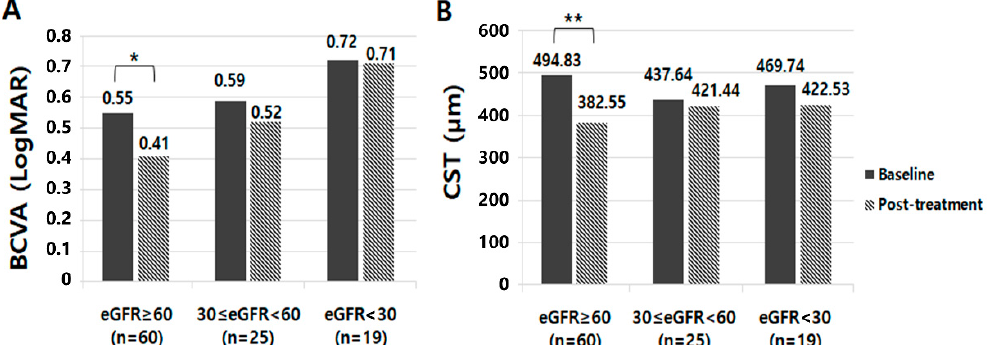
Figure 1. Comparison of the treatment responsiveness of diabetic macular edema after three- monthly consecutive IVBIs according to renal function. ( A ) After three-monthly consecutive IVBIs, BCVA (* p < 0.001) were significantly improved in the preserved renal function group; however, there was no difference in BCVA in the moderate and severe CKD groups, respectively ( p = 0.758, p = 1.00). However, in the intergroup analysis, the difference between the three groups in BCVA im- provement was not statistically signi fi cant ( − 0.14 ± 0.28 vs. − 0.07 ± 0.44 vs. − 0.01 ± 0.35, p = 0.214). ( B ) After three-monthly consecutive IVBIs, CST (** p < 0.001) were significantly improved in the pre- served renal function group; however, there was no difference in CST in the moderate and severe CKD groups, respectively ( p = 0.758, p = 1.00). In the intergroup analysis after three-monthly con- secutive IVBIs, CST was significantly improved in the preserved renal function group compared with the moderate and severe CKD groups (112.28 ± 148.83 vs. 16.20 ± 159.12 vs. 47.21 ± 128.22, p =